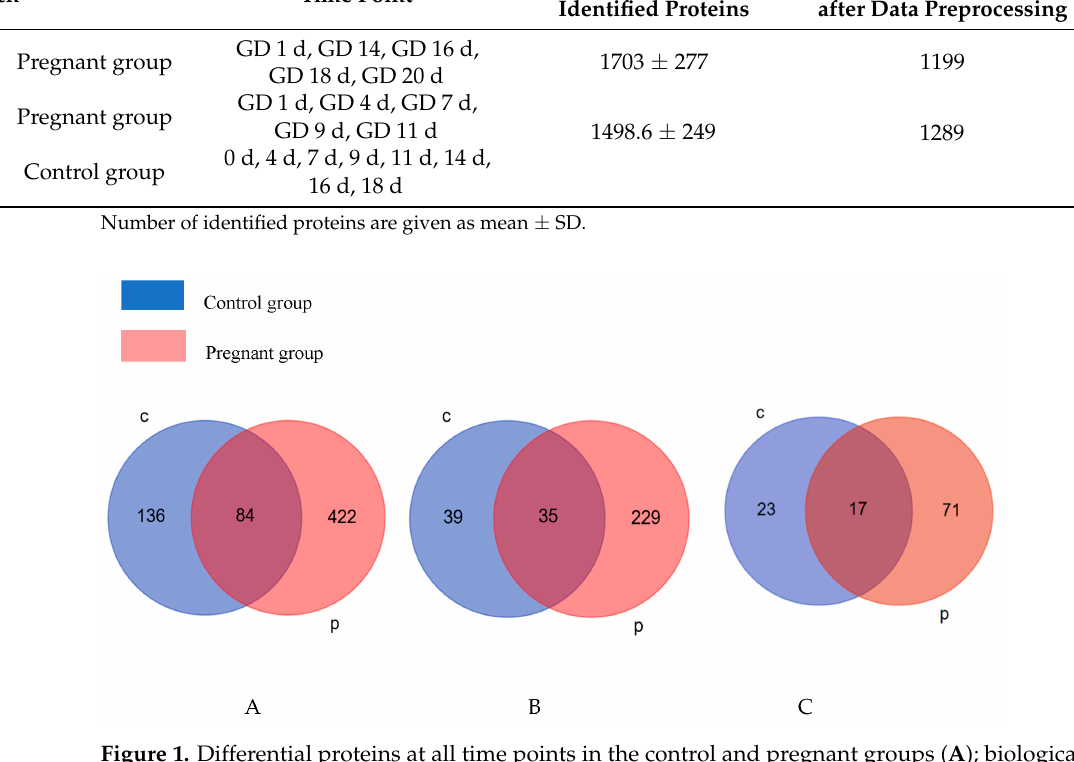
Figure 1. Differential proteins at all time points in the control and pregnant groups ( A ); biological processes at all time points in the two groups ( B ); IPA classical biological pathways at all time points in both groups ( C ). C: control group; P:pregnant group.